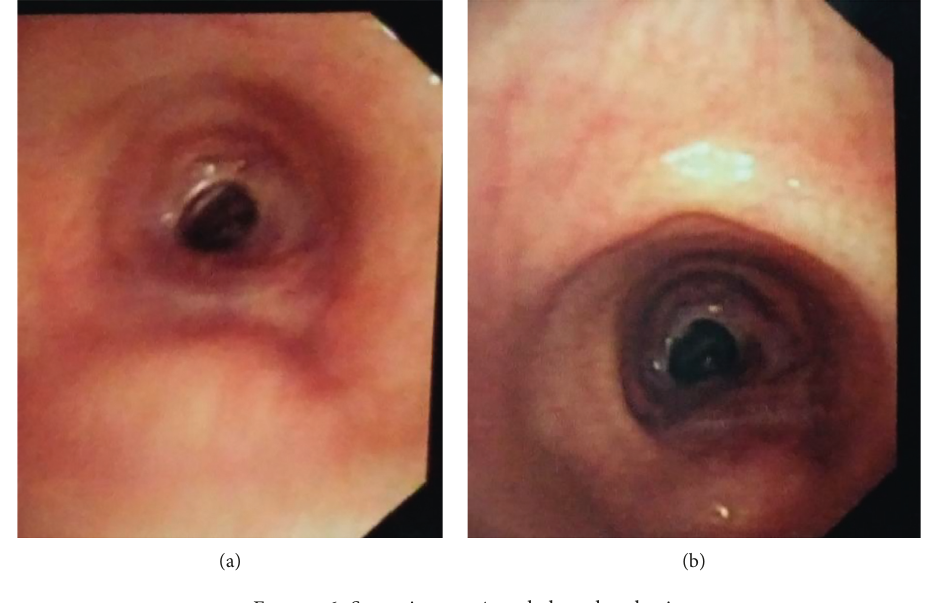
Figure 6: Stenosis seen 4cm below the glottis.